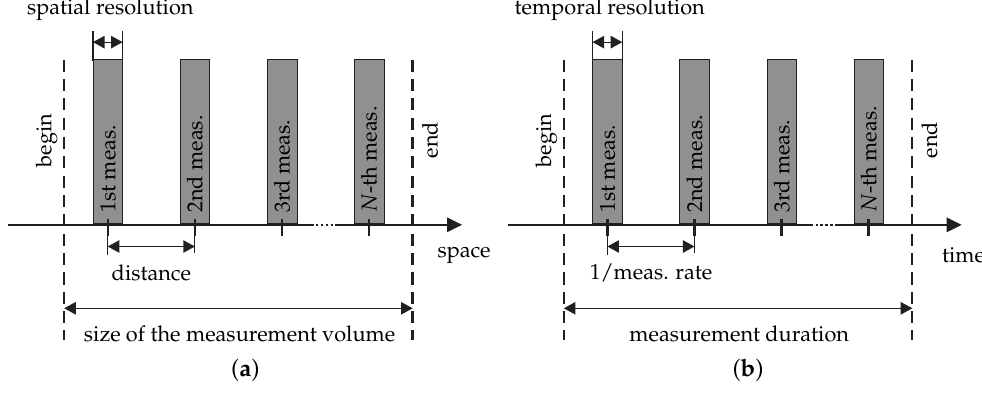
Figure 5. Illustration of the terms ( a ) spatial resolution, spatial distance of the measurements and size of the measurement volume along one space dimension and ( b ) temporal resolution, measurement rate and measurement duration.